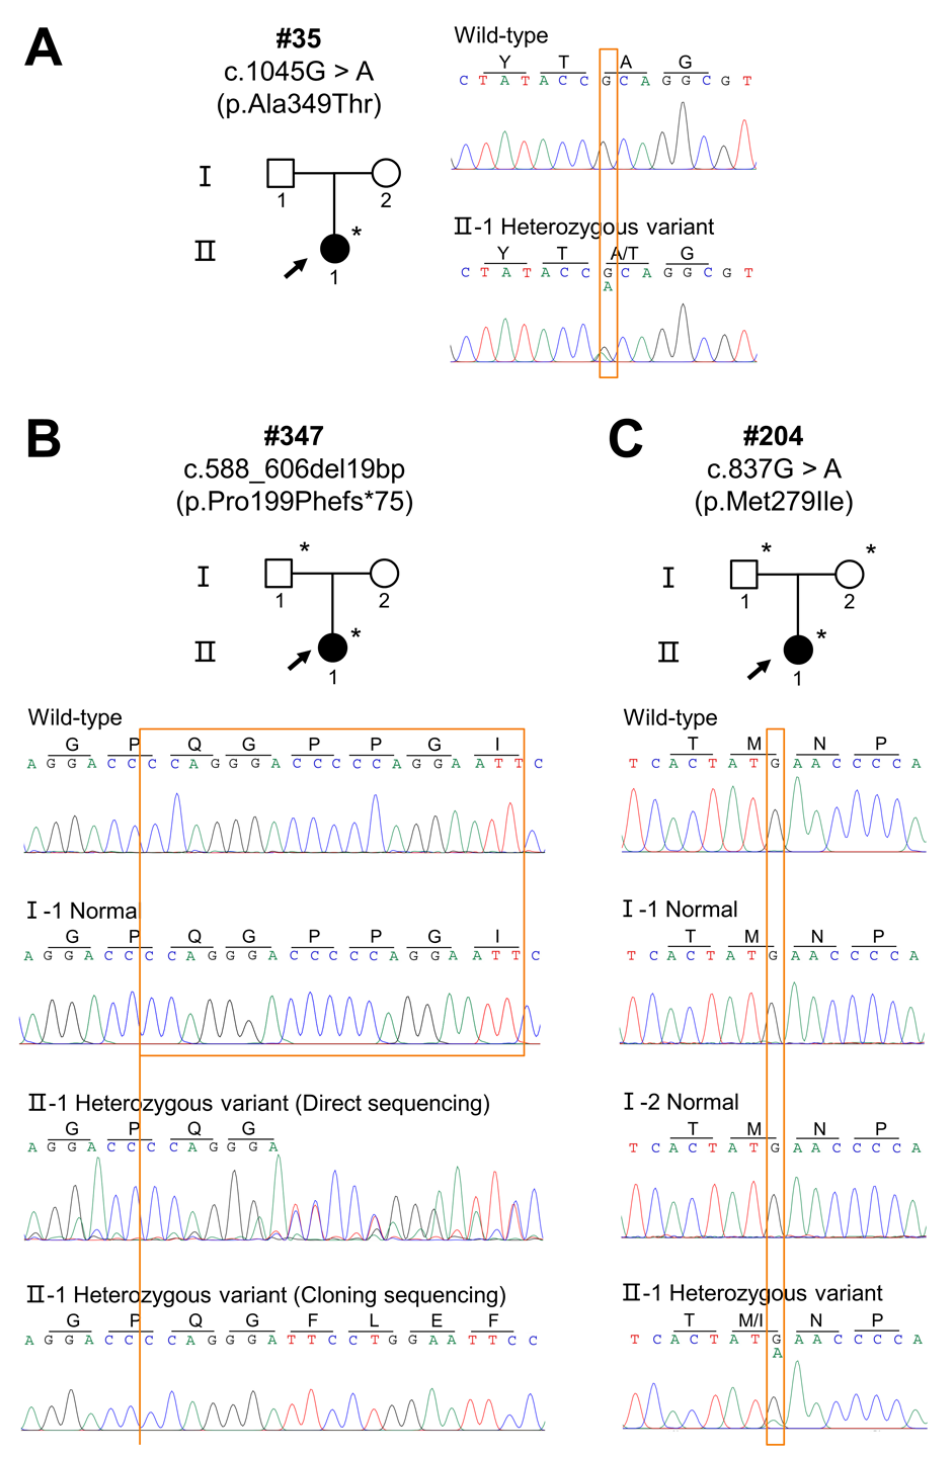
Figure 2. Sequencing chromatograms of three female patients with XLHED. ( A ) Sequencing chromatograms show a heterozygous missense variant (c.1045G>A, p.Ala349Thr) identified in patient #35. ( B ) Sequencing chromatograms show a heterozygous frameshift variant (c.588_606del19bp, p.Pro199Phefs*75) identified in patient #347. ( C ) Sequencing chromatograms show a heterozygous missense variant (c.837G>A, p.Met279Ile) identified in patient #204. Black arrows indicate the proband in each family. Solid circles and squares represent the individuals with HED. Asterisks indicates that DNA samples are available. Black circles represent the individuals with XLHED. Black arrows indicate the probands.